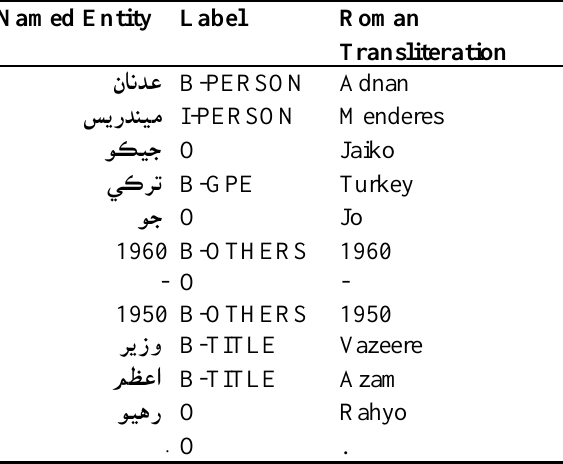
Table 3. The format of the SiNER dataset; the Roman transliteration of each token is given for the ease of reading.